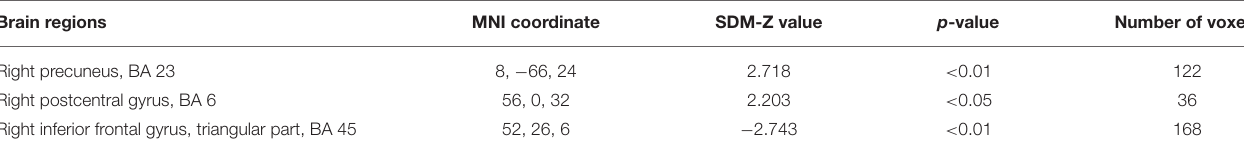
TABLE 6 | Clusters of ALFF differences before and after acupuncture on depression. Brain regions